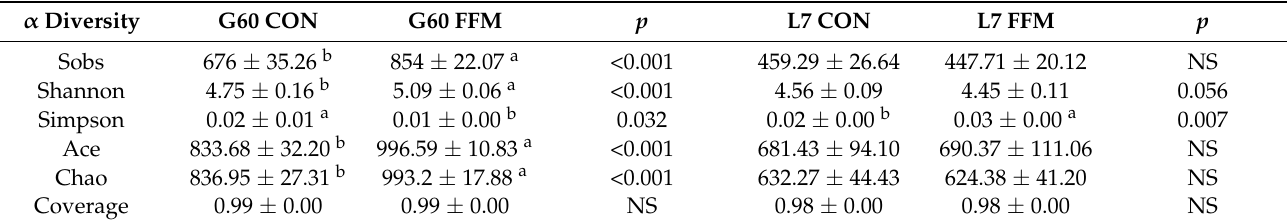
Table 2. The α diversity of sows’ feces on G60 and L7.